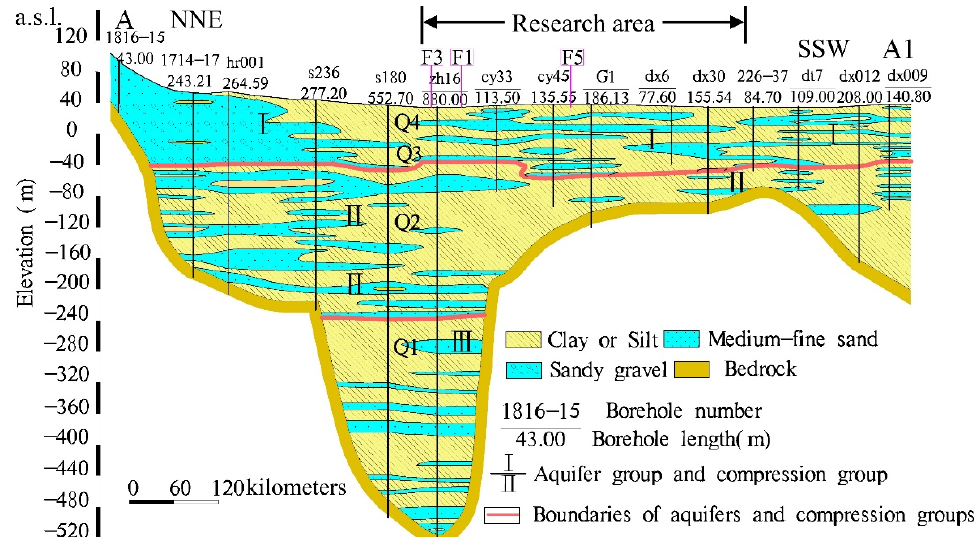
Figure 2. Hydrogeological profile (the geological data are derived from [53,57]). The aquifer system can be vertically divided into three main aquifer groups: the first compression group (Q4 + Q3), the second compression group (Q2) and the third compression group (Q1).